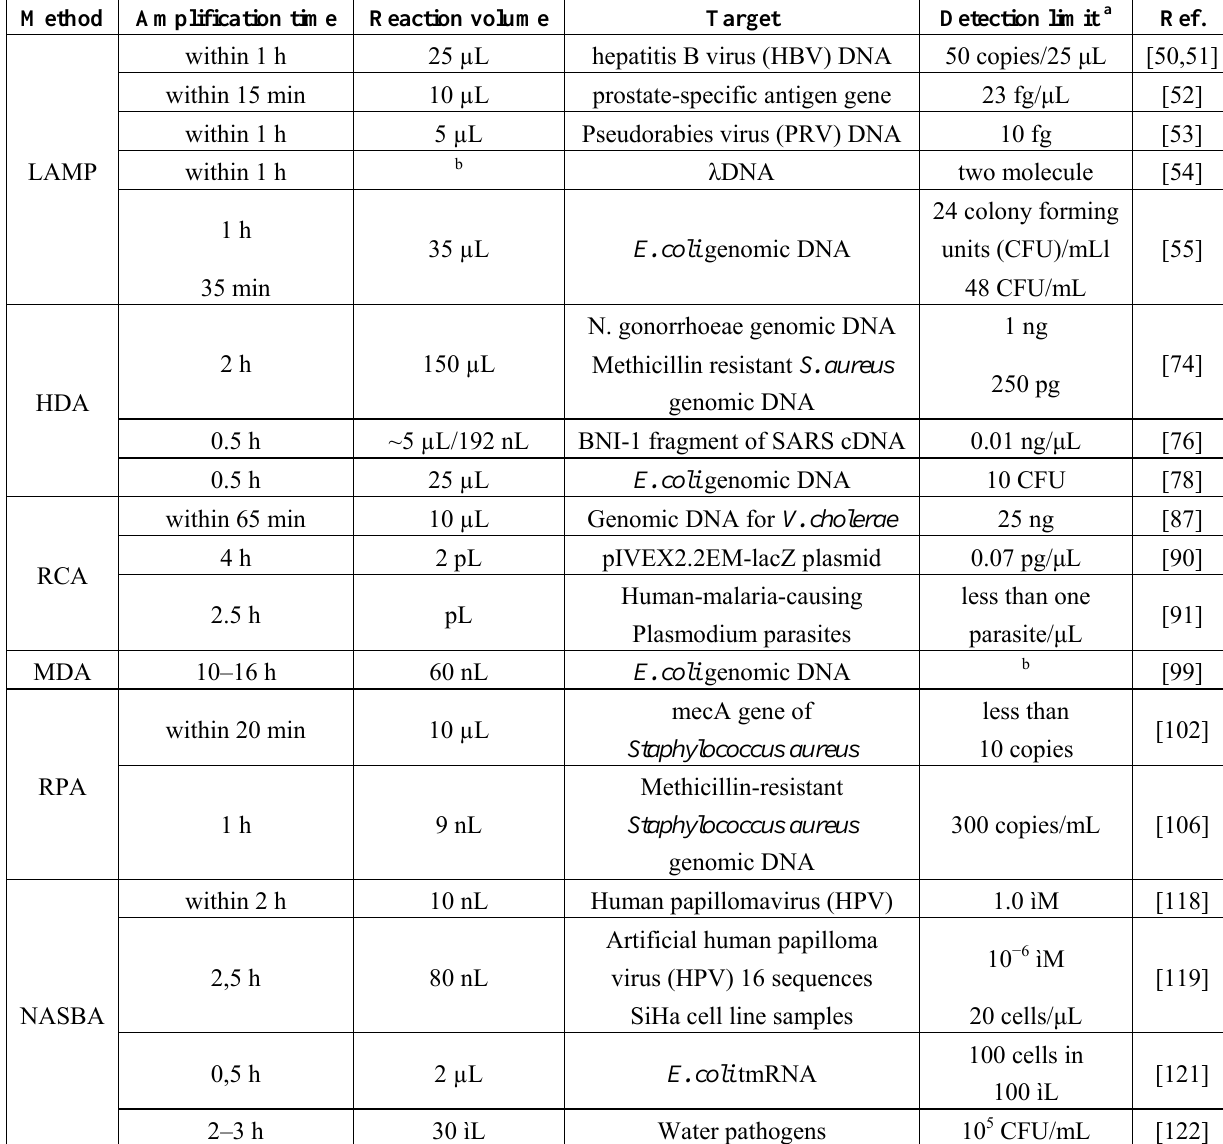
Table 1. Summary of isothermal nucleic acid amplification